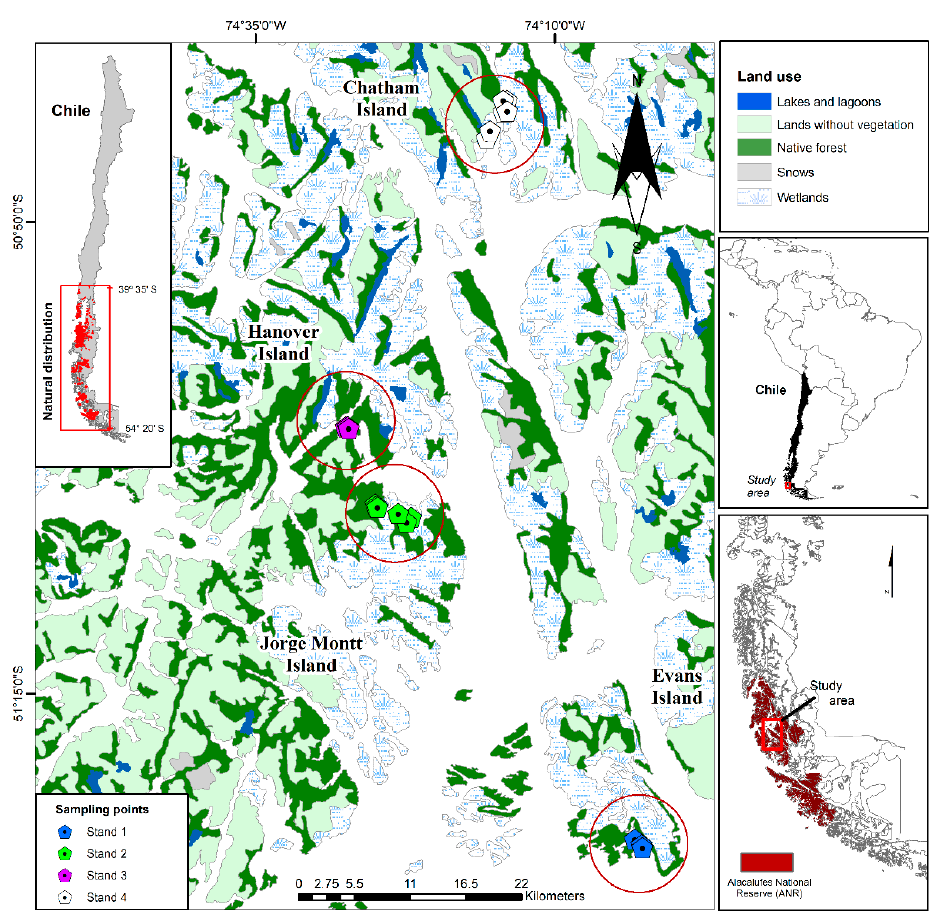
Figure 1. General location of the study area and sample units established in Kawésqar National Park (KNP), Chile.